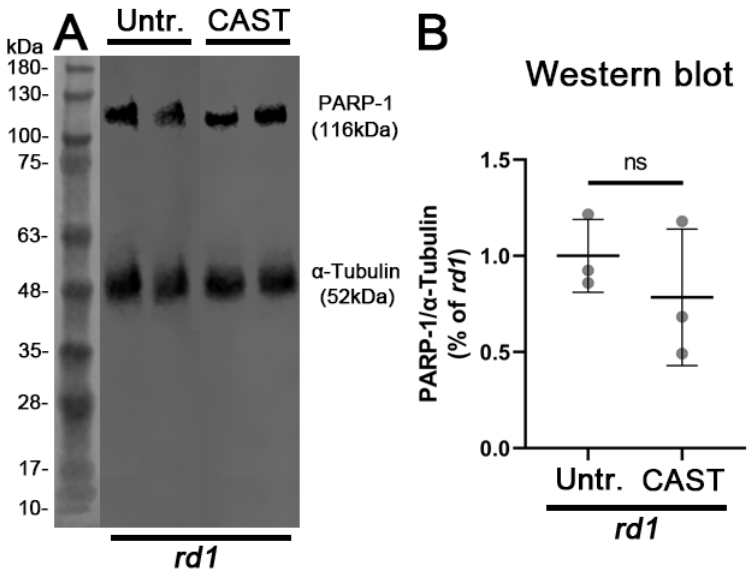
Figure A3. Calpain does not cleave PARP-1 in rd1 retina. Retinal explants derived from rd1 mice were cultured from post-natal day 5 to 11 and treated with 20 μM calpastatin (CAST). ( A ) Western blot (WB) for PARP-1 on tissue lysates derived from untreated (Untr.) and CAST-treated rd1 retinal explant cultures. Full-length PARP-1 displays a molecular weight of approx. 116 kDa. Molecular weight standard shown on left, α -tubulin was used as loading control. ( B ) Densitometric quantification of PARP-1 vs. α -tubulin expression. Note that there was no significant change in expression of full-length PARP-1 between rd1 untreated and CAST-treated samples. WB images are representative for blots obtained from at least three independent experiments. n.s. = not significant.